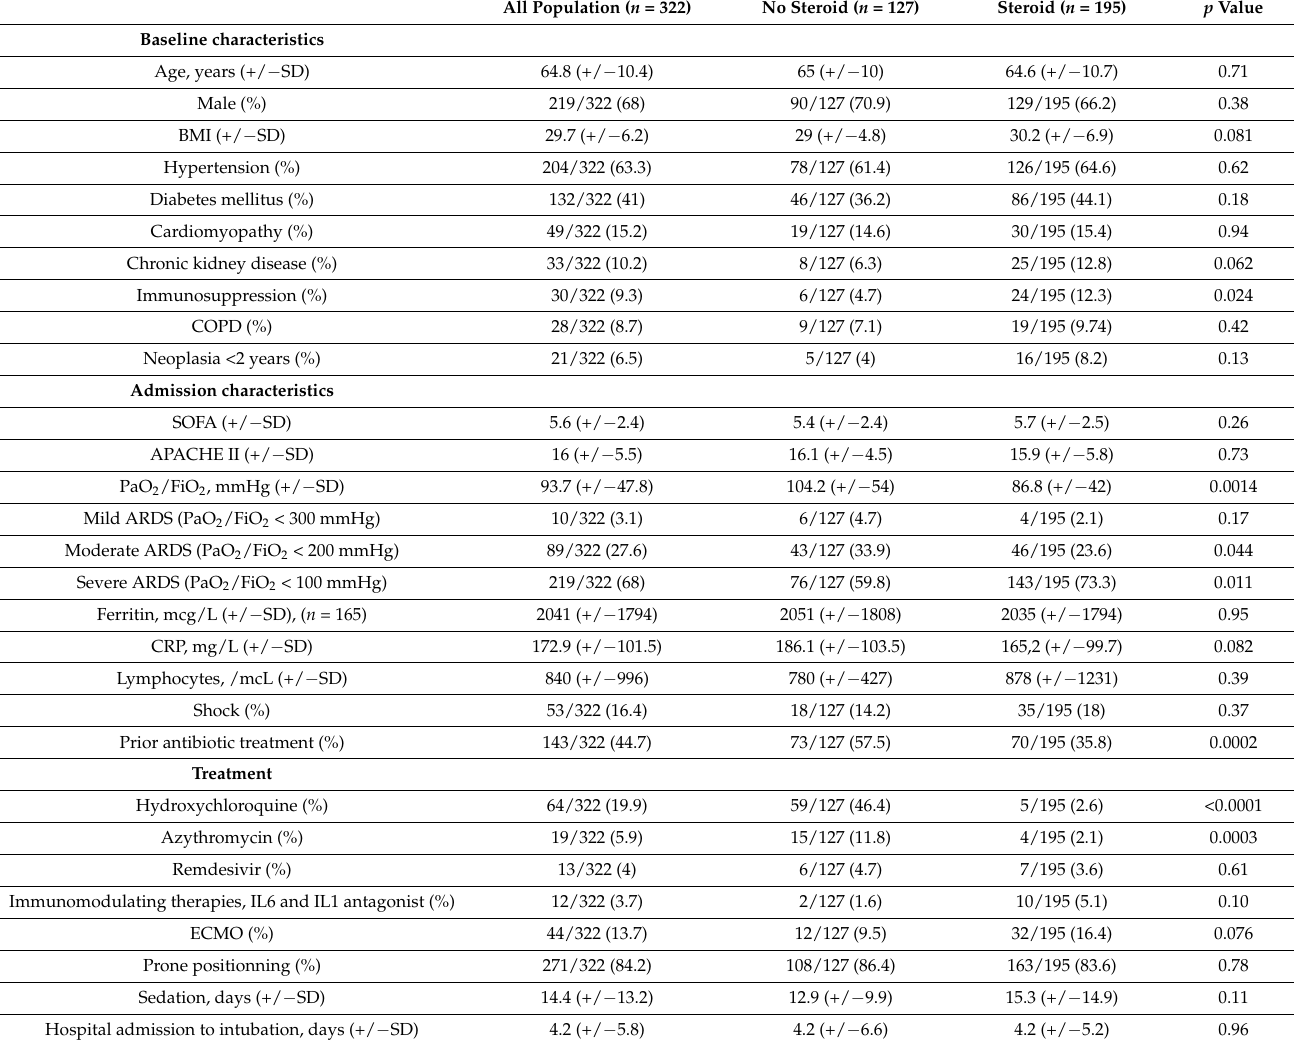
Table 1. Characteristics between patients receiving early corticosteroid therapy and those who did